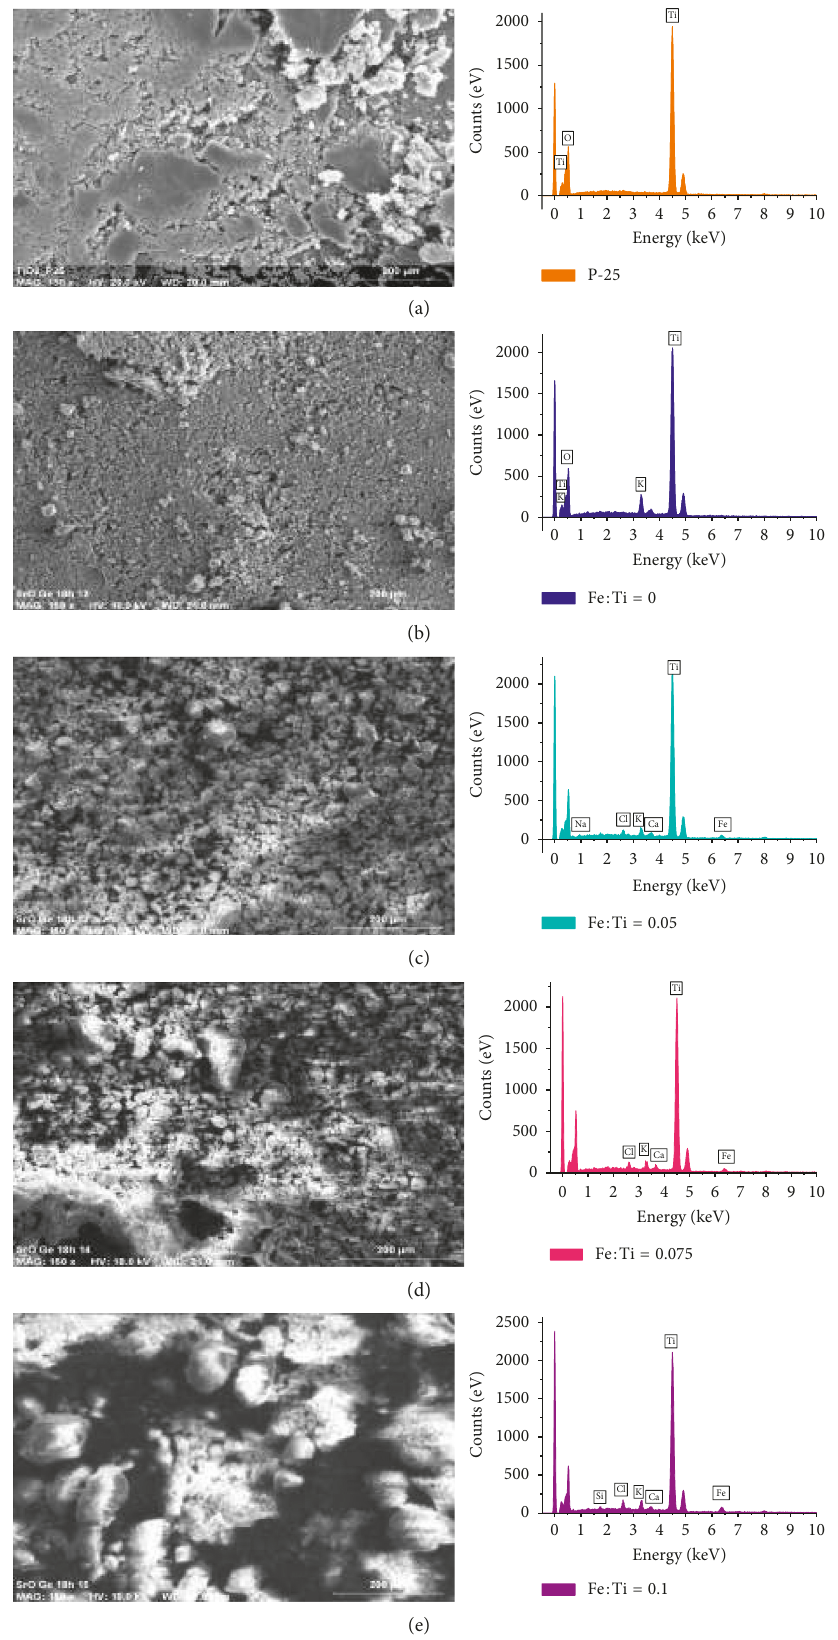
Figure 9: SEM micrographs and EDS spectrum of (a) P-25 TiO magnification: